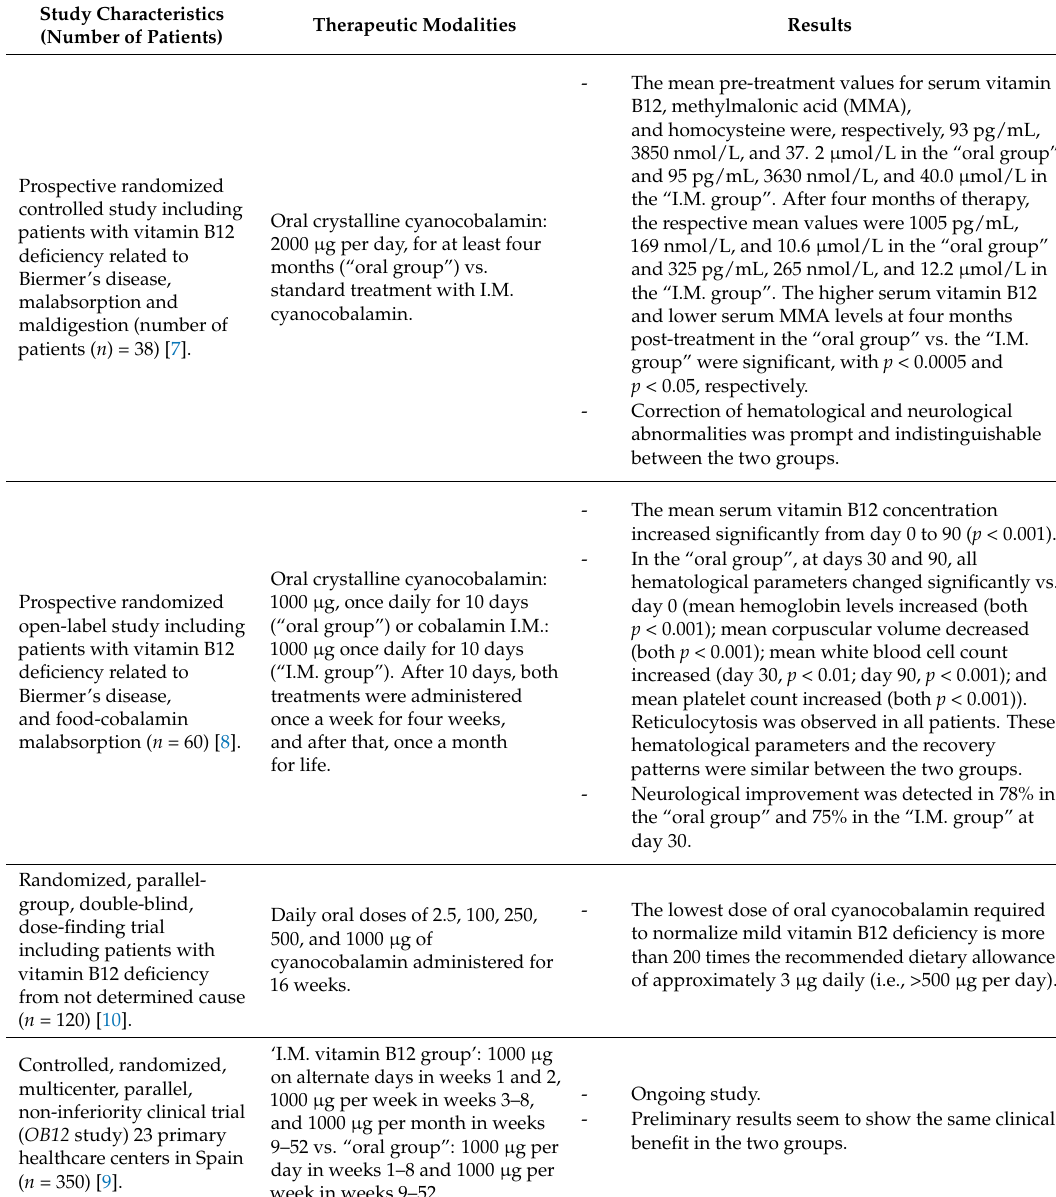
Table 1. Prospective randomized controlled studies of oral vitamin B12 treatment (number of studies = 4). Study Characteristics Therapeutic Modalities (Number of Patients)